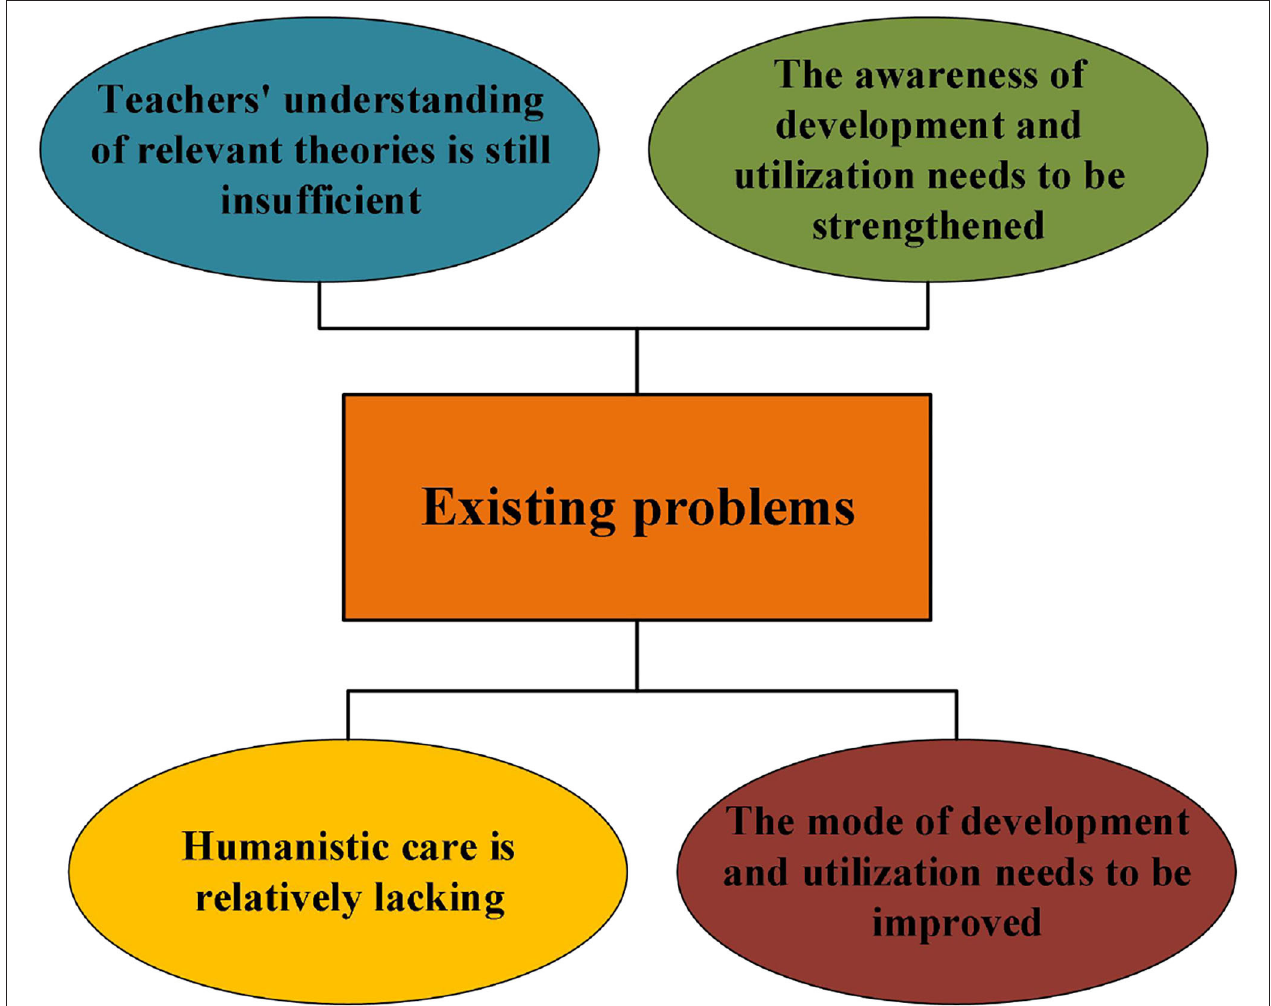
FIGURE 6 | Problems in the GCR DAU of primary school PE.